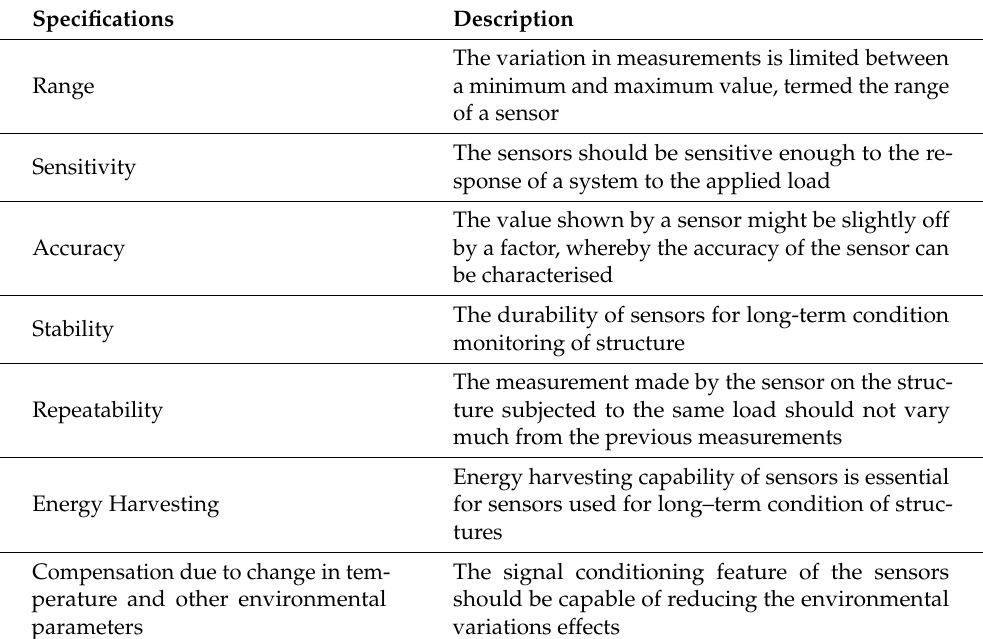
Table 6. Fundamental characteristics of sensors used for damage detection of composite materials. Specifications